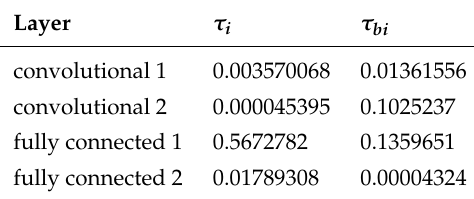
Table 4. A posteriori uncertainty reduced model.